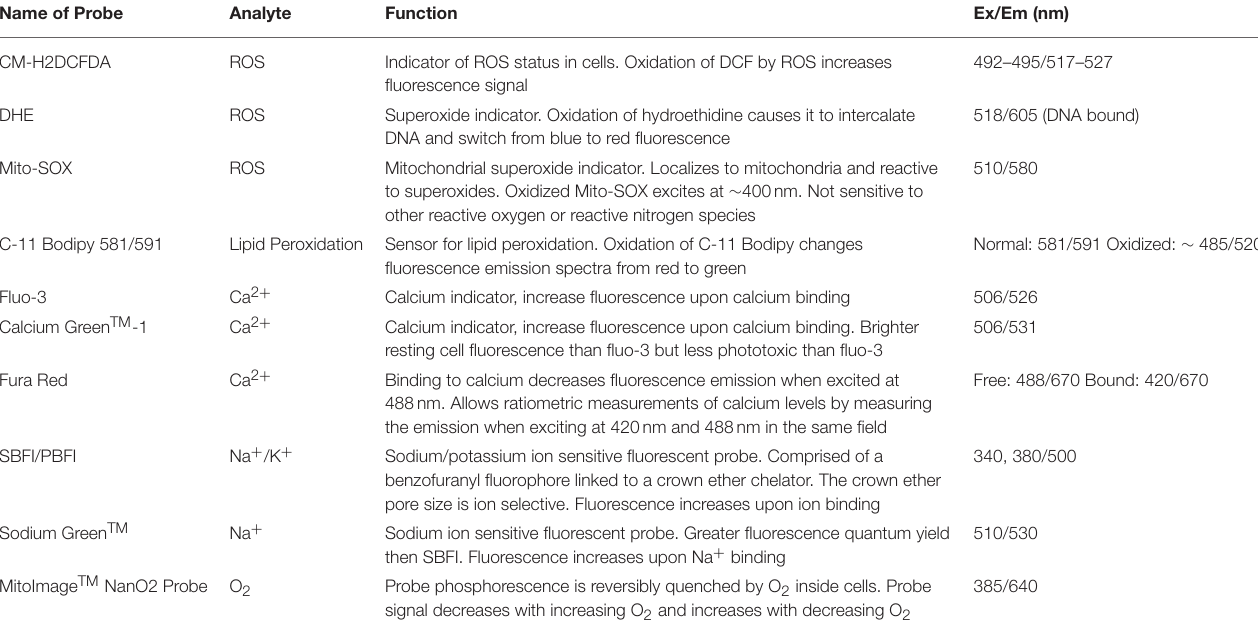
TABLE 2 | Common molecular probes for the detection of intracellular biomolecules, ions and reactive oxygen species in neural